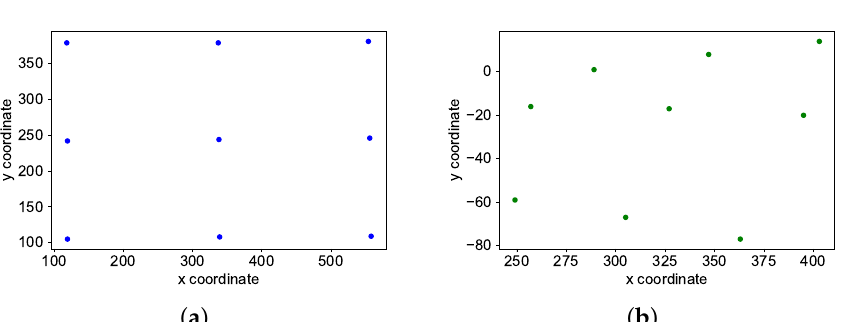
Figure 2. Data processing procedure. JS .